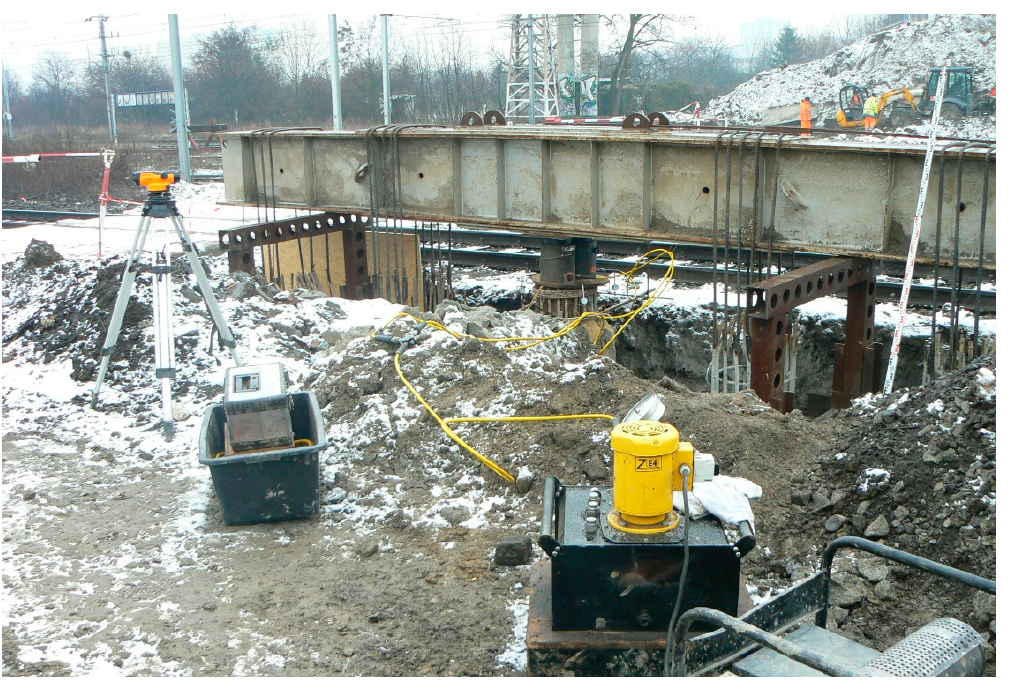
Figure 1. The basic idea of the SLT appliance with anchoring piles.